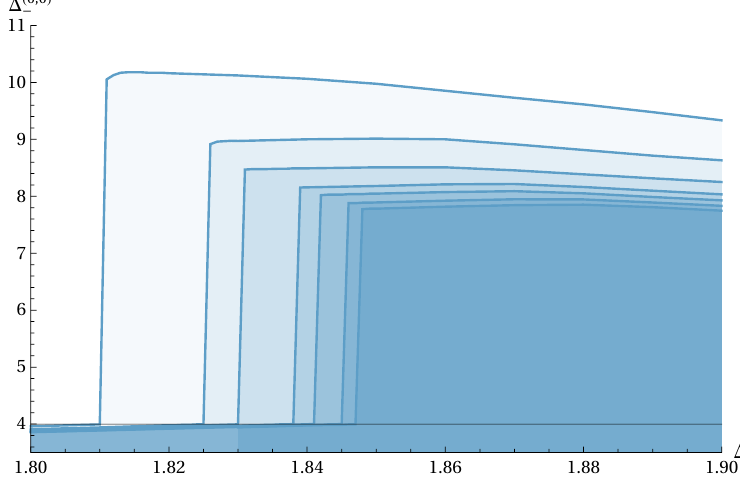
Figure 8 . Upper bound on the dimension of the (cid:12)rst charged scalar operator in the proximity of the jump as shown in (cid:12)gure 7. Di(cid:11)erent lines corresponds to increasing number of derivatives